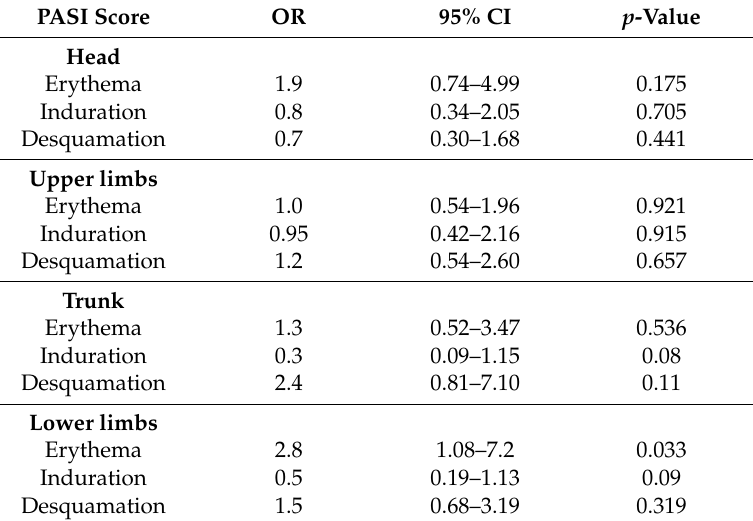
Table 2. IAS and